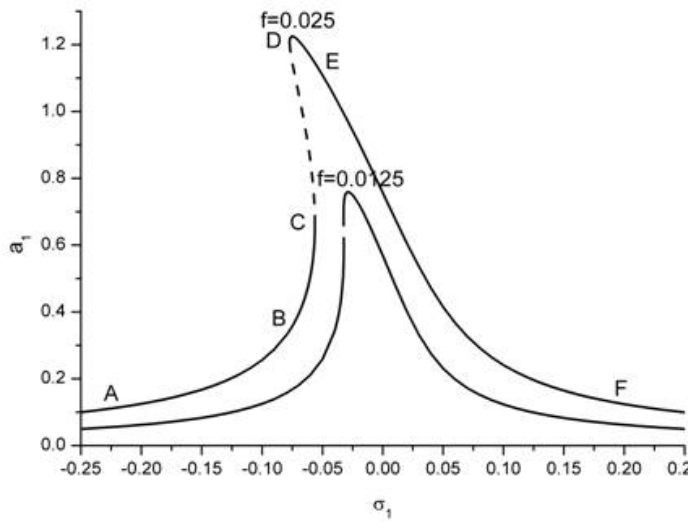
Fig. 1. Effect of varying the excitation amplitude on the frequency-response curves of the